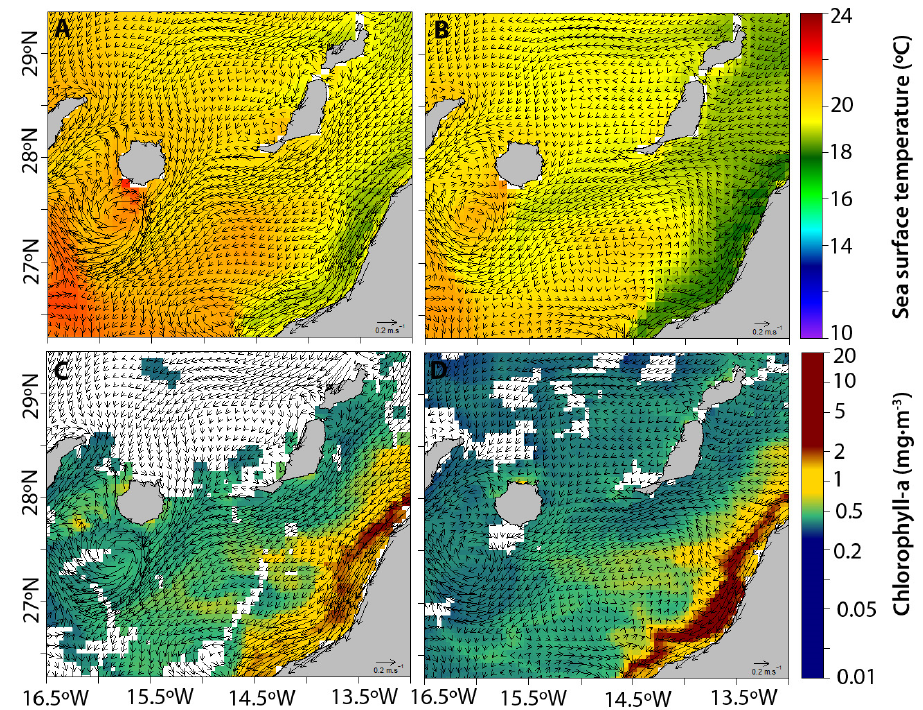
Figure 5. ( A , B ) Remotely sensed image of sea surface temperature and ( C , D ) chlorophyll a concen- tration between Gran Canaria Island and the coastal zone off northwest Africa during 26th of May ( A , C ) and 2 June ( B , D ), 2021. Data was downloaded from the Copernicus Marine platform and NASA’s OceanColorWeb. Current direction and velocity are represented by black arrows. Velocity is proportional to the length of the arrows.